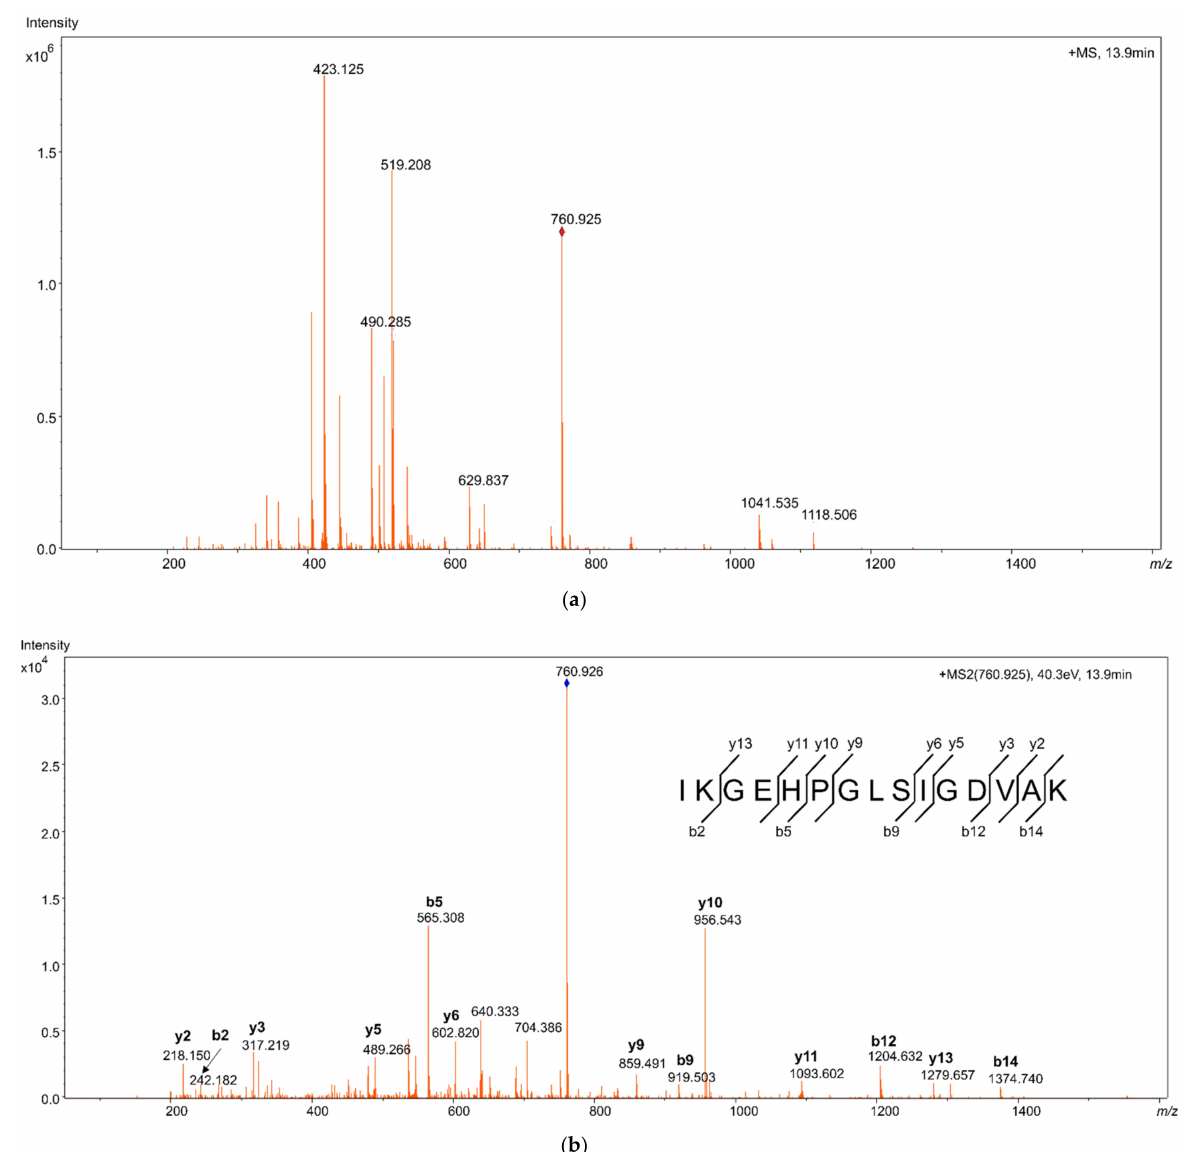
Figure 2. Mass spectrum from high resolution mass spectrometry (HRMS), identifying high mobility group box 1 (HMGB1) peptide IKGEHPGLSIGDVAK ( a ) Molecular ion mass spectrum showing the peptide mass [M + 2H] 2+ with m / z 760.9245, at 13.9 min. ( b ) Fragment ion mass spectrum of m / z 760.9245 showing series of y- and b-ions identifying the amino acid